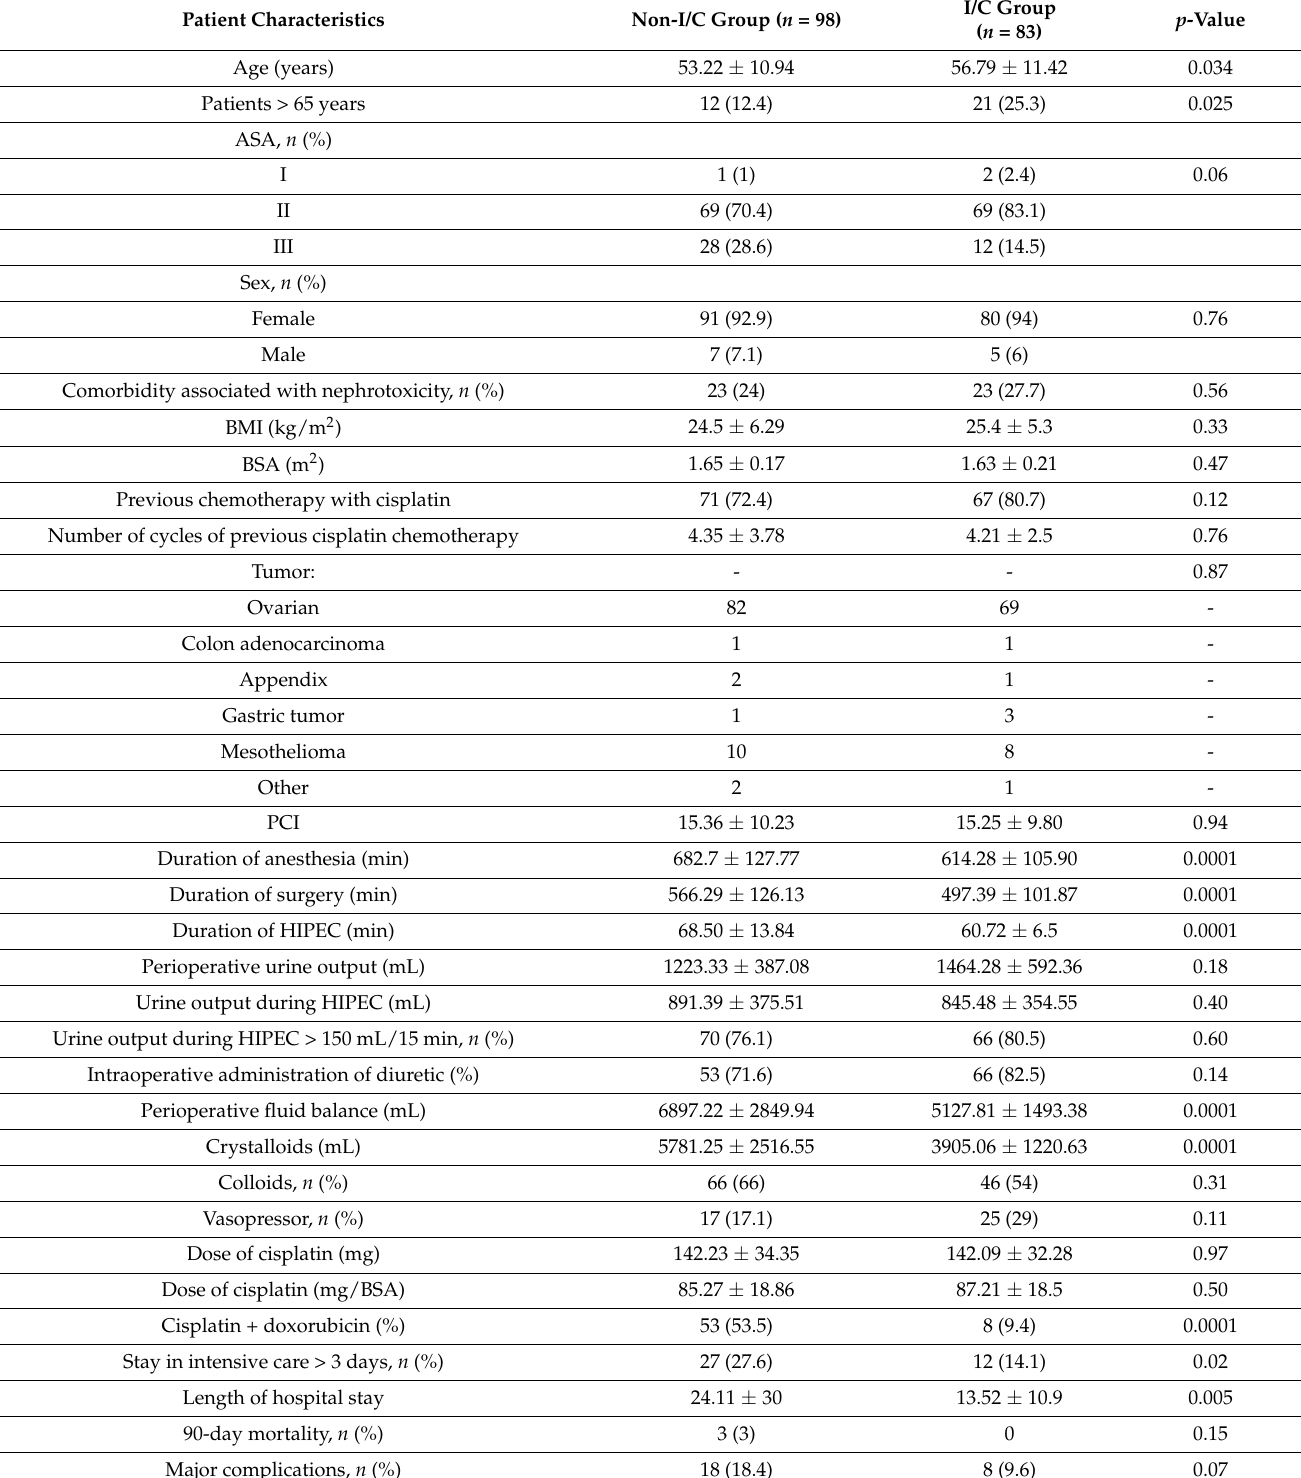
Table 1. Baseline